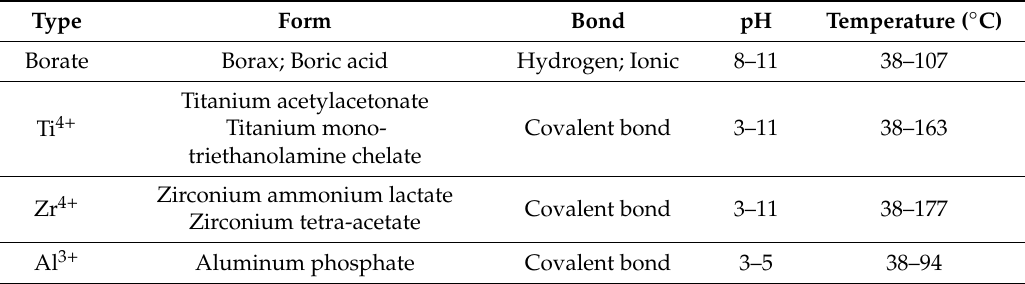
Table 5. The crosslinkers of Guar gum